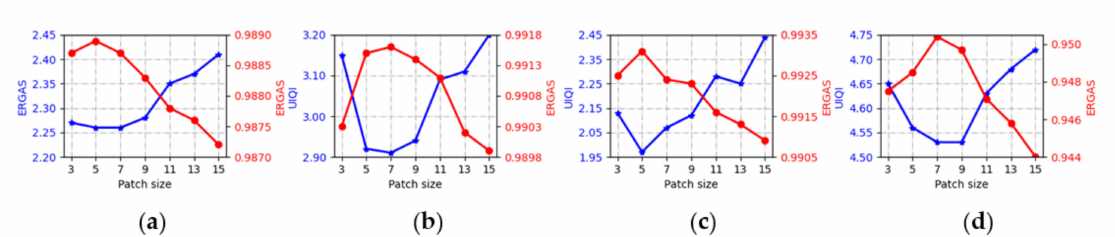
Figure 8. The relative dimensionless global error in synthesis (ERGAS) and universal image quality index (UIQI) values with respect to the patch size of HS image. ( a ) University of Pavia; ( b ) Pavia City center; ( c ) Washington DC Mall; ( d ) San